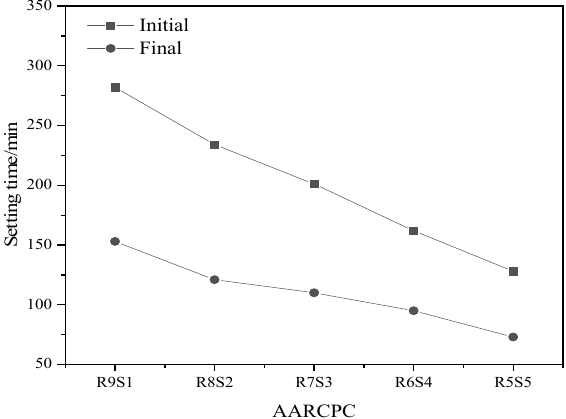
Figure 5. Setting time of AARCPC with different slag content.